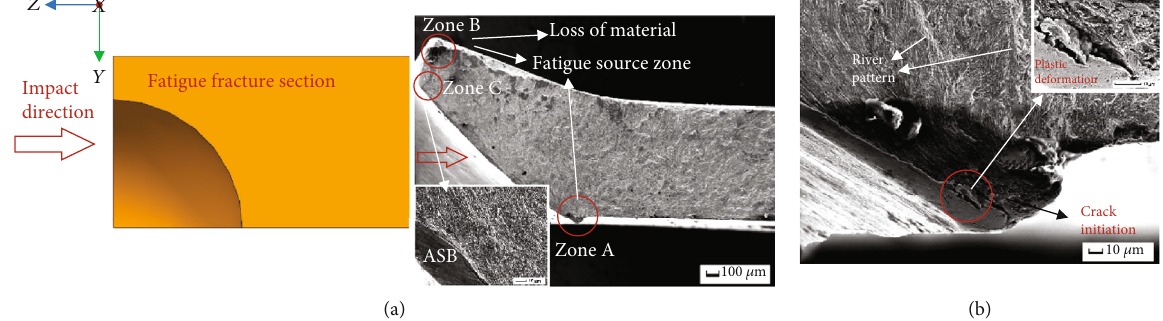
Figure 12: The microscopic features of fatigue fracture on No. 9 fl at plate specimen: (a) global view; (b) Zone A.